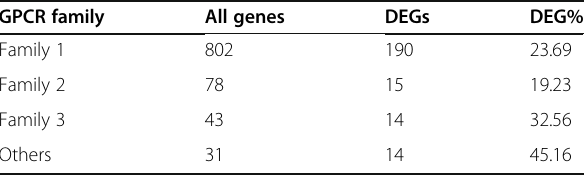
Table 2 The composition of Acropora tenuis GPCR families. DEGs were detected by multigroup comparison using 0, 1,